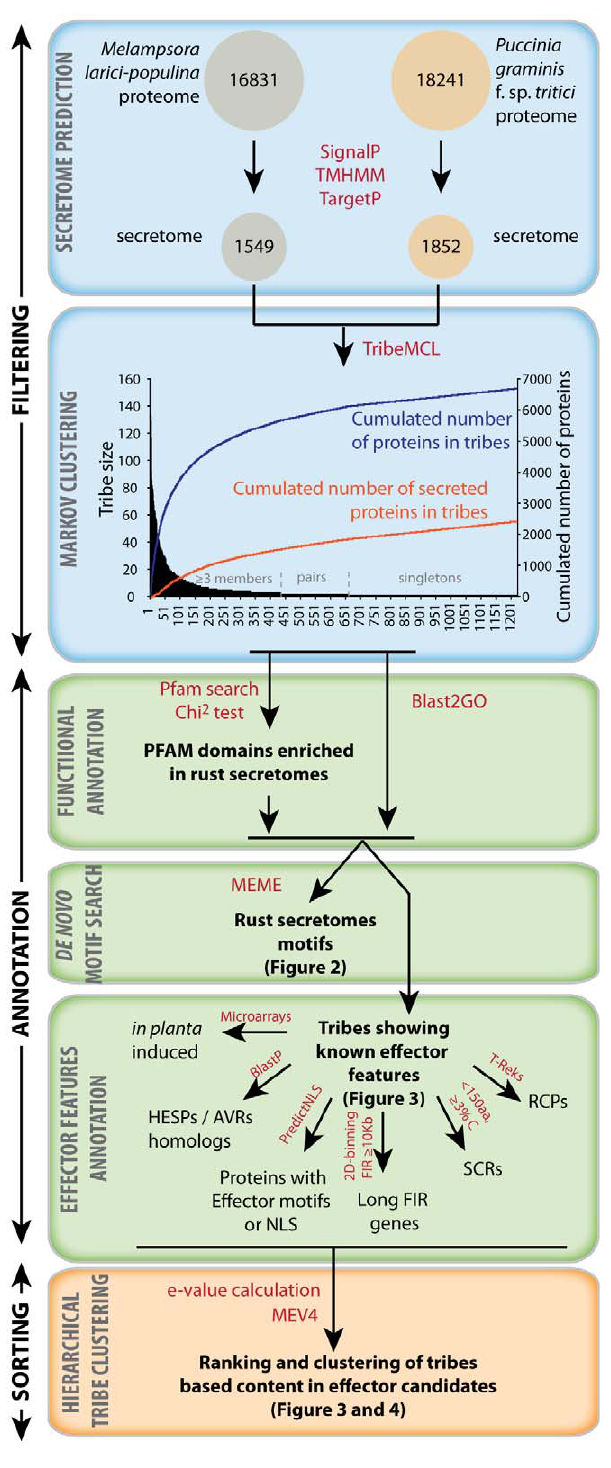
Figure 1. Bioinformatic pipeline for the clustering of secreted protein families and classification and ranking of effector candidates. The pipeline is composed of six major steps delimited by boxes. Step 1 (Secretome prediction) identifies secreted proteins from the predicted proteomes. A total of 1549 and 1852 secreted proteins were predicted from M. larici-populina and P. graminis f. sp. tritici proteomes, respectively. Step 2 (Markov clustering) groups secreted and non-secreted proteins according to sequence similarities to secreted proteins. A total of 435 secreted protein families (tribes)